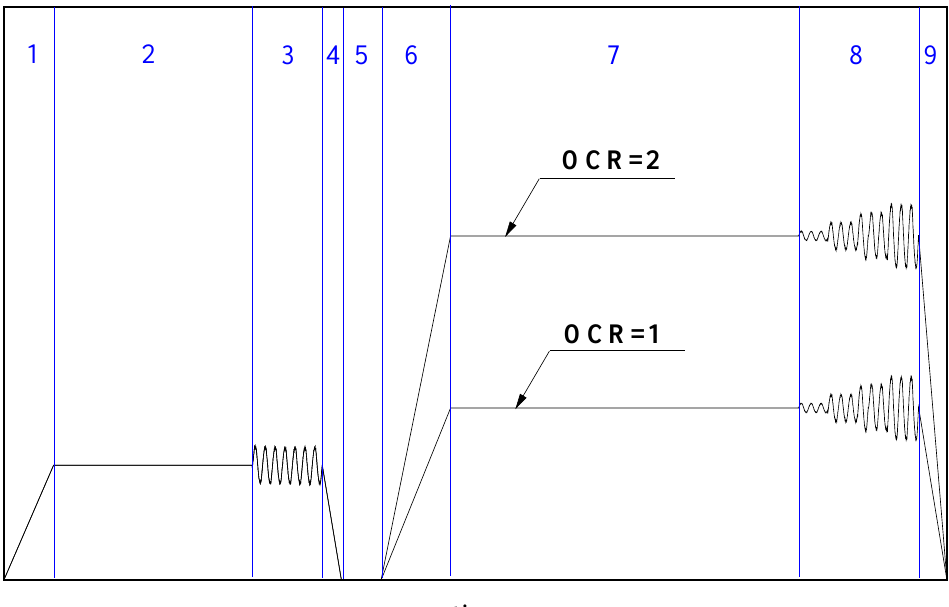
Figure 6. Schematic diagram of the load path of the pre-shock reconsolidation cyclic shear process: stage 1: load for pre-shock, stage 2: consolidation for pre-shock, stage 3: pre-shock, stage 4: unload after pre-shock, stage 5: stabilization and saturation of the specimens, stage 6: load for cyclic shear, stage 7: consolidation for cyclic shear, stage 8: cyclic shear, and stage 9: unload after cyclic shear.